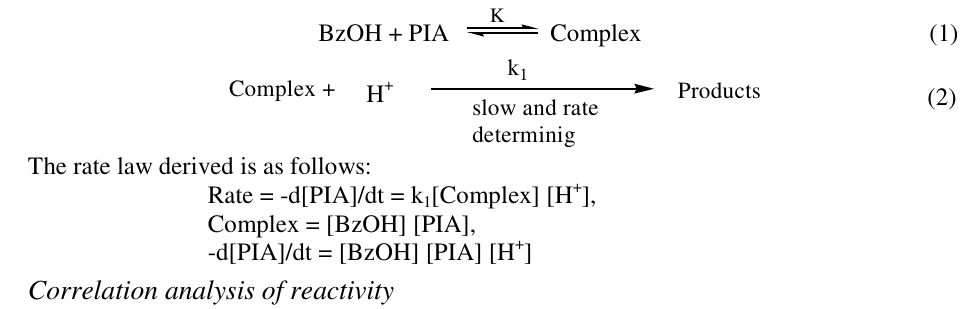
Table 2 Rate constants and activation parameters for the oxidation of meta - and para - substituted benzyl alcohols by PIA k